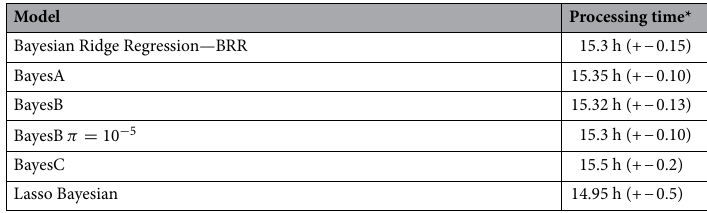
Table 2. Estimates of time averages for solving different Bayesian models with 10 6 iterations, burn-in of 10 4 ,